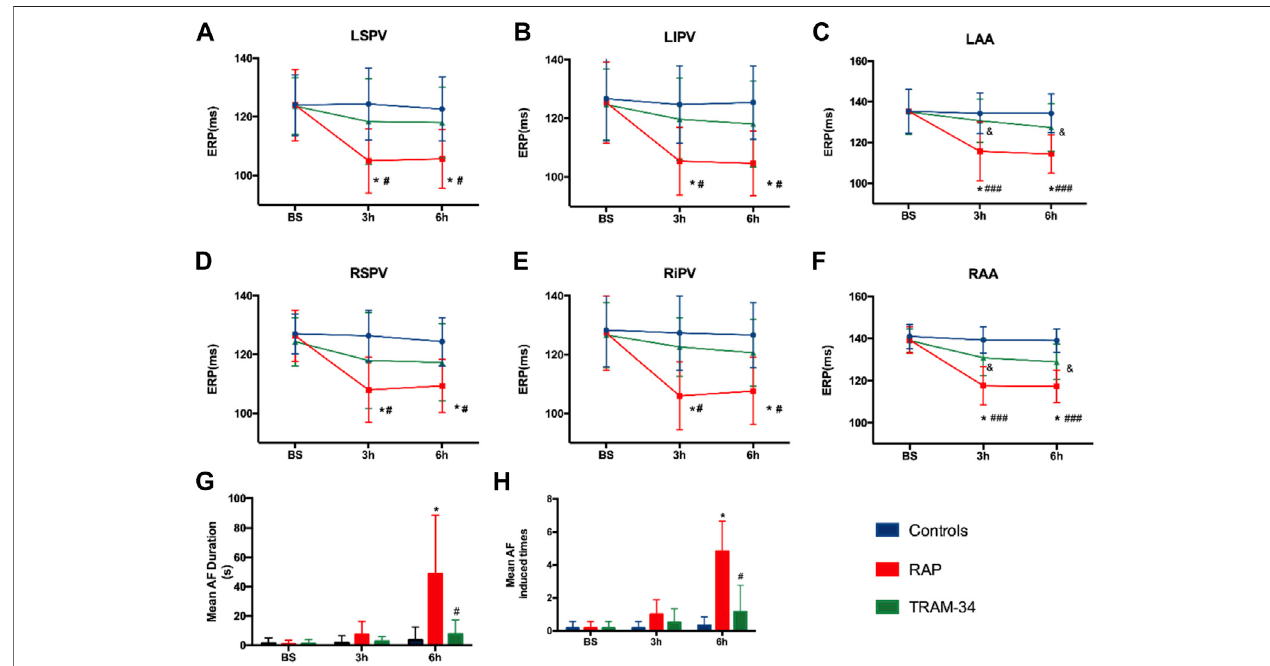
FIGURE 3 | Results of electrophysiological measurements. (A – F) ERP changes at RAA, LAA, RSPV, RIPV, LSPV, and LIPV during 6-h stimulation. * p < 0.05 vs baseline (G) Mean AF duration, and (H) Mean AF inducibility changes in the Control, RAP, and TRAM-34 groups. * p < 0.05 vs baseline; # p < 0.05 vs the RAP group. Abbreviations: RAA, right atrial appendage, LAA, left atrial appendage RSPV, right superior pulmonary vein, RIPV, right inferior pulmonary vein, LSPV, left superior pulmonary vein, LIPV, left inferior pulmonary vein, ERP, effective refractory period, AF, atrial fi brillation.